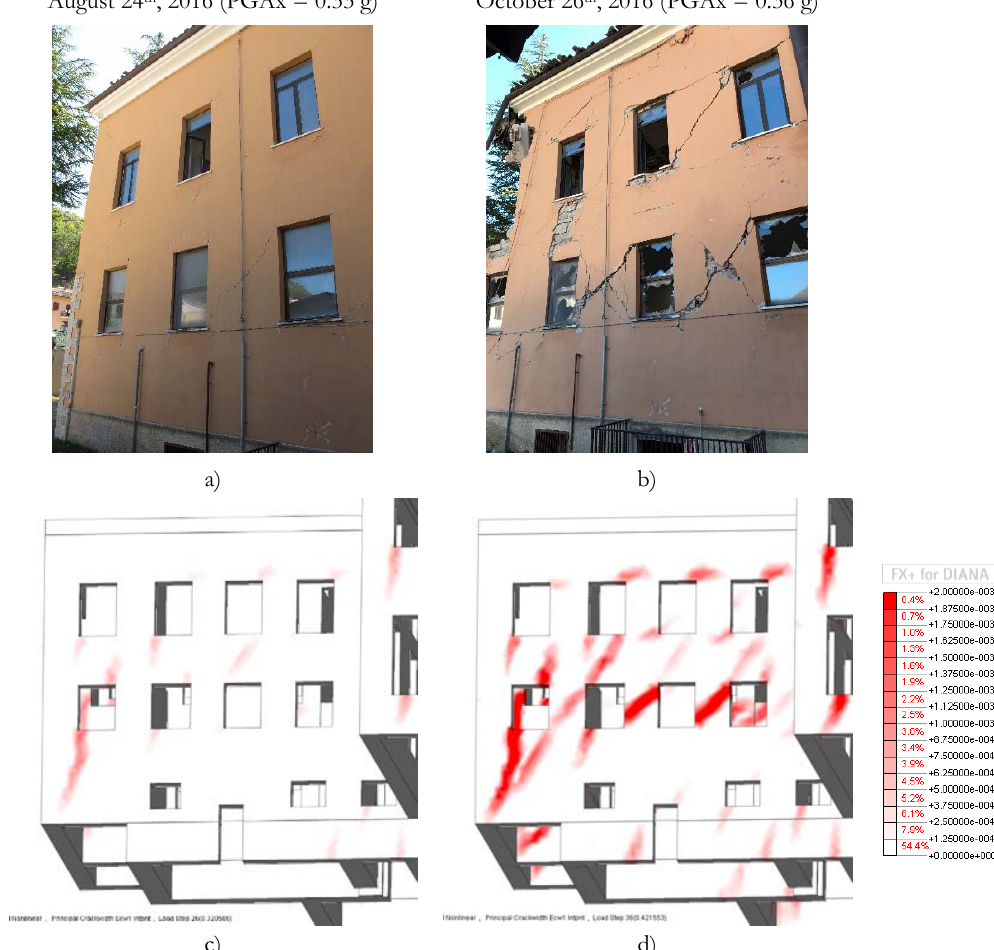
Figure 20: Correlation between the real and numerical damage occurred in the west external wall of body B due to the August 24 th (left) and October 26 th (right) earthquakes: a-b) cracks observed in-situ [11, 12], c) crack pattern in terms of principal crack width for a horizontal load of 0.32 g in the +Y direction, d) crack pattern in terms of principal crack width for a horizontal load of 0.42 g in the +Y